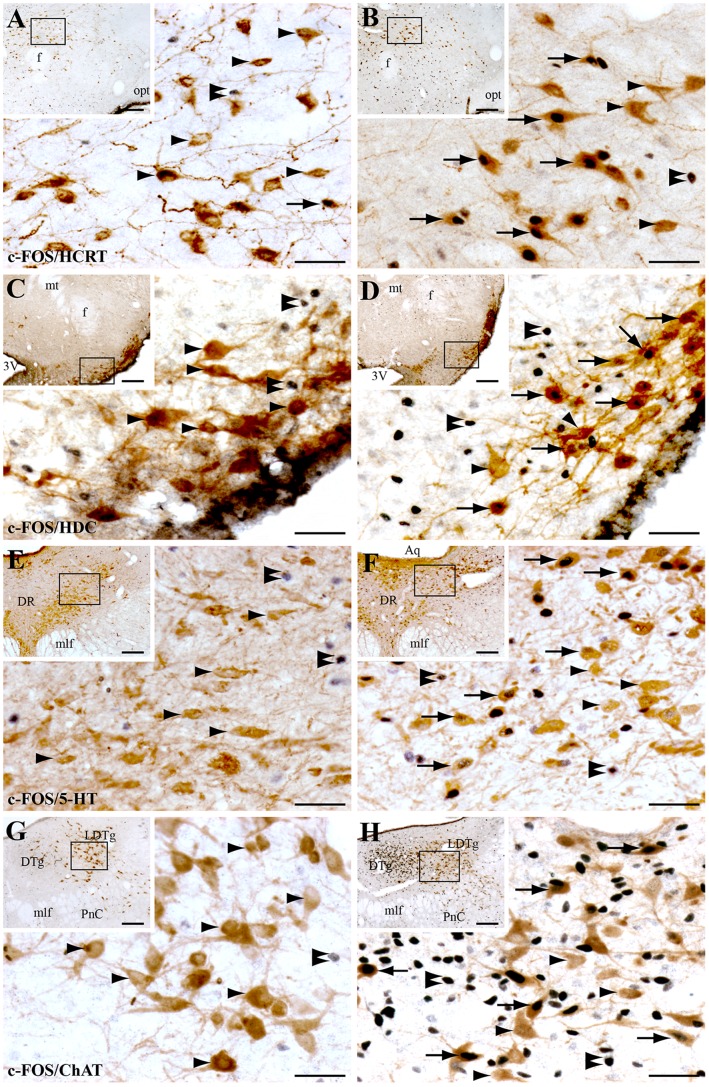
Level of c-FOS expression in wake promoting systems after NaCl or muscimol injection in the DPGi.Photomicrographs showing double immunostained sections for c-FOS (black nuclear staining) and hypocretin (HCRT, A, B), histamine (HDC, C, D), serotonin (5-HT, E, F) and choline acetyltransferase (ChAT, G, H) (brown cytoplasmic staining) 3 h after NaCl (left panel) or muscimol (right panel) injection in the DPGi. The areas illustrated at high power magnification are depicted in a box on the low power photomicrographs. Black arrows point out double-labeled neurons. Black arrowheads show singly labeled neurons for HCRT, HDC, 5-HT or ChAT and double arrowheads c-FOS singly labeled neurons. Scale bars, 50 µm for high enlargements and 200 µm for low enlargements. Abbreviations: 3V, 3rd ventricle; Aq, aqueduct; DR, dorsal raphe; DTg, dorsal tegmental nucleus; f, fornix; LDTg, laterodorsal tegmental nucleus; mlf, medial longitudinal fasciculus; mt, mammillothalamic tract; opt, optical tract; PnC, pontine reticular nucleus, caudal part.